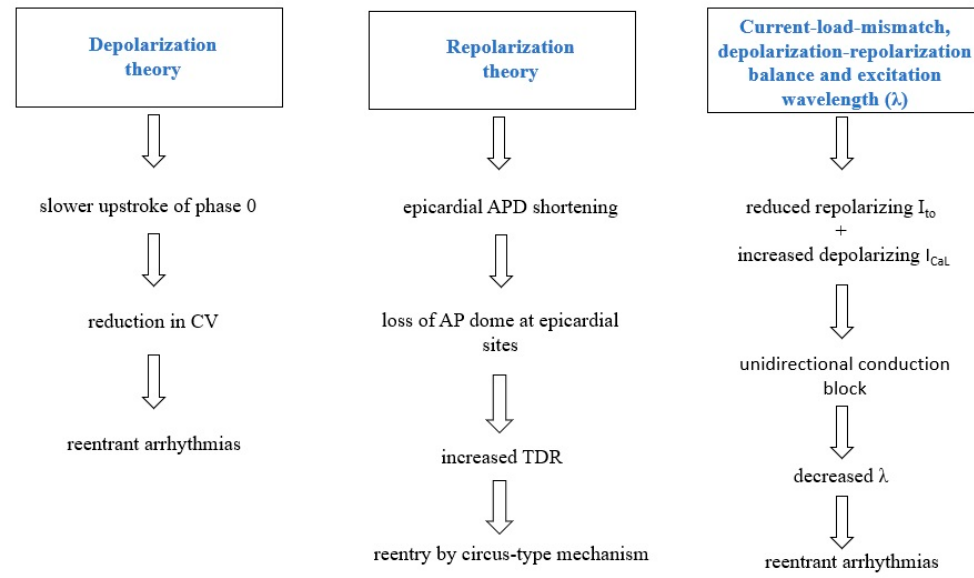
Figure 1. Schematic representation of the three electrophysiological theories behind BrS; AP (action potential); APD (action potential duration); CV (conduction delay); I to (transient outward potassium current); I CaL (L-type Ca 2+ current); TDR (transmural dispersion of repolarization).